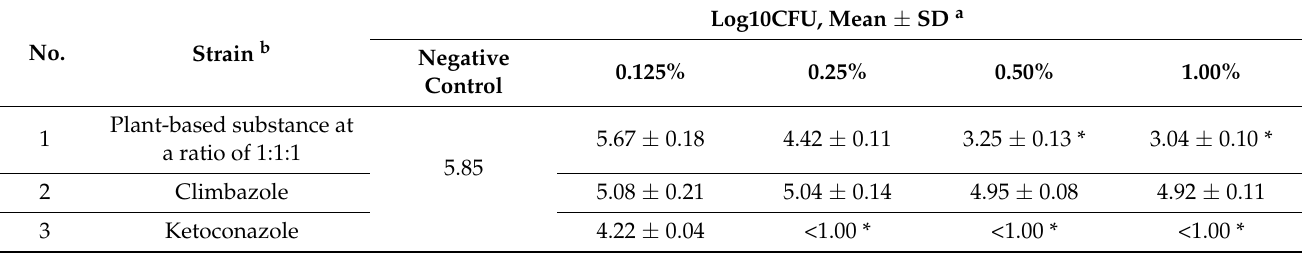
Table 6. Antifungal activity of substances against M. furfur